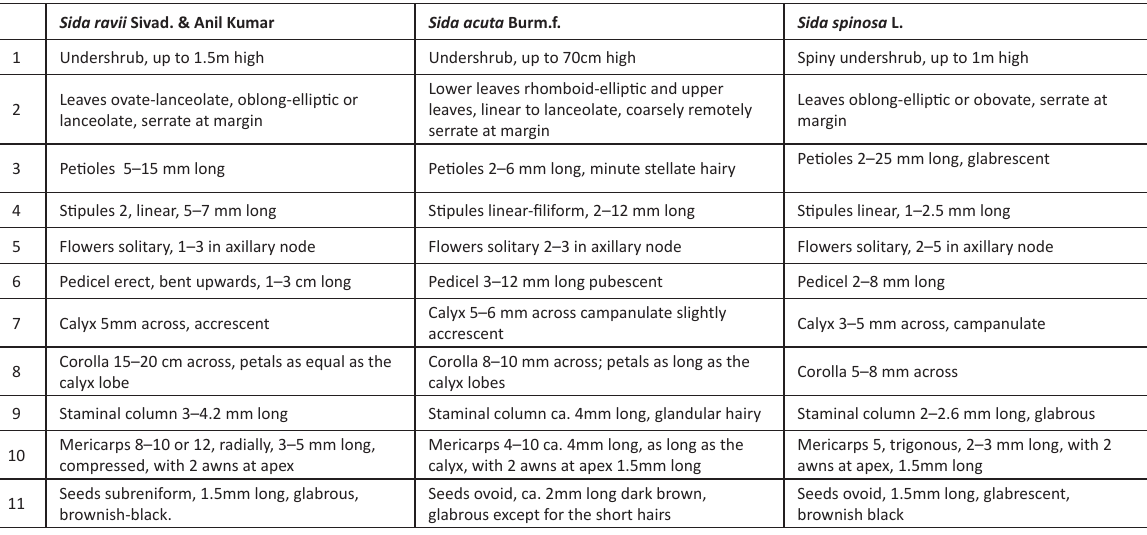
Table 1. Species that is closely related to Sida acuta and Sida spinosa Sida ravii Sivad. & Anil